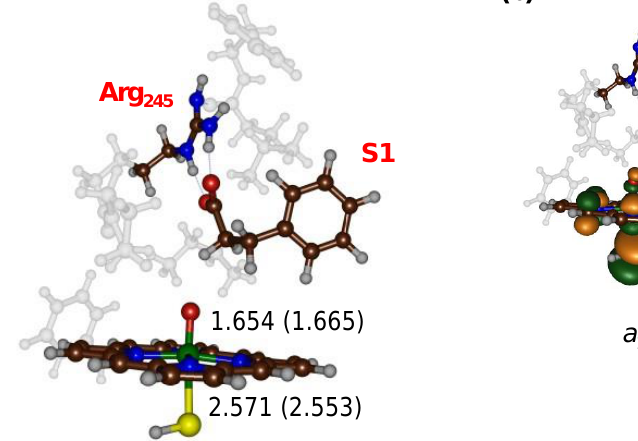
Figure 2. ( a ) Optimized geometries of the S1 -bound reactant complexes 4 Re S1 ( 2 Re S1 ) with bond lengths in angstroms; ( b ) singly occupied molecular orbitals of 4,2 Re S1 .